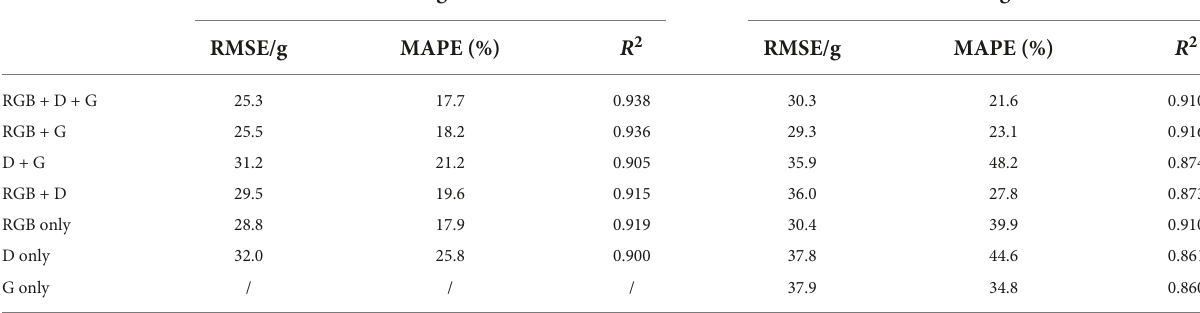
TABLE 5 Fresh weight estimation result of different models in the test set. With data augmentation Without data